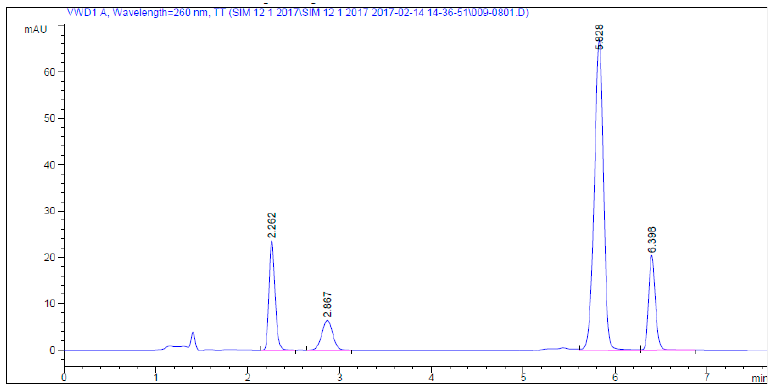
Figure 2. HPLC chromatogram of 2.0 µ g / mL for each of daclatasvir (2.262 min), sofosbuvir (2.867 min), ledipasvir (5.828 min), and simeprevir (6.398 min) under the described chromatographic